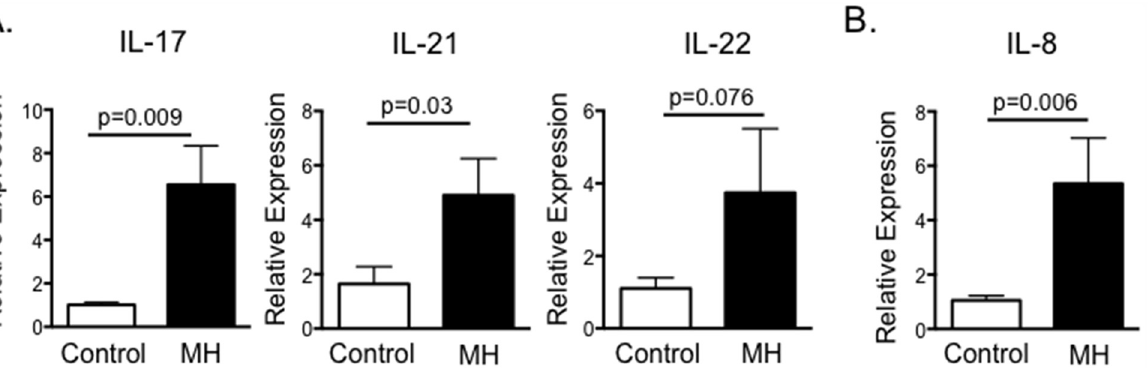
Fig 6. M . haemolytica infection induces IL-17 and Th17 cytokine production. Calves (n = 4) were infected with a field strain of M . haemolytica via endoscope-guided inoculation as described in Materials and Methods. Control calves were sham inoculated (n = 4). On day 3 after infection, animals were sacrificed and their lungs analyzed by qPCR for expression of IL-17, IL-21 and IL-22 (A); and for expression of IL-8 (B). Results were normalized to the housekeeping gene RPS-9, and expressed relative to samples from uninfected control calves. Results are pooled from one experiment. Data represent means ±